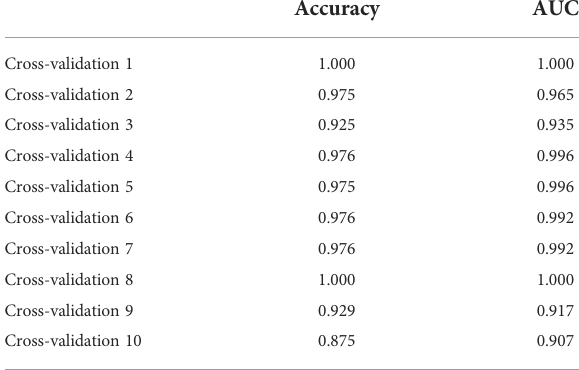
TABLE 2 The 10-fold cross-validation results.